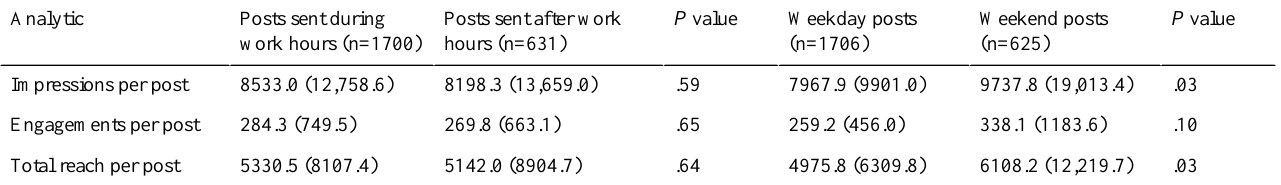
Table 6. Facebook post analytics, mean (SD), as a function of time and